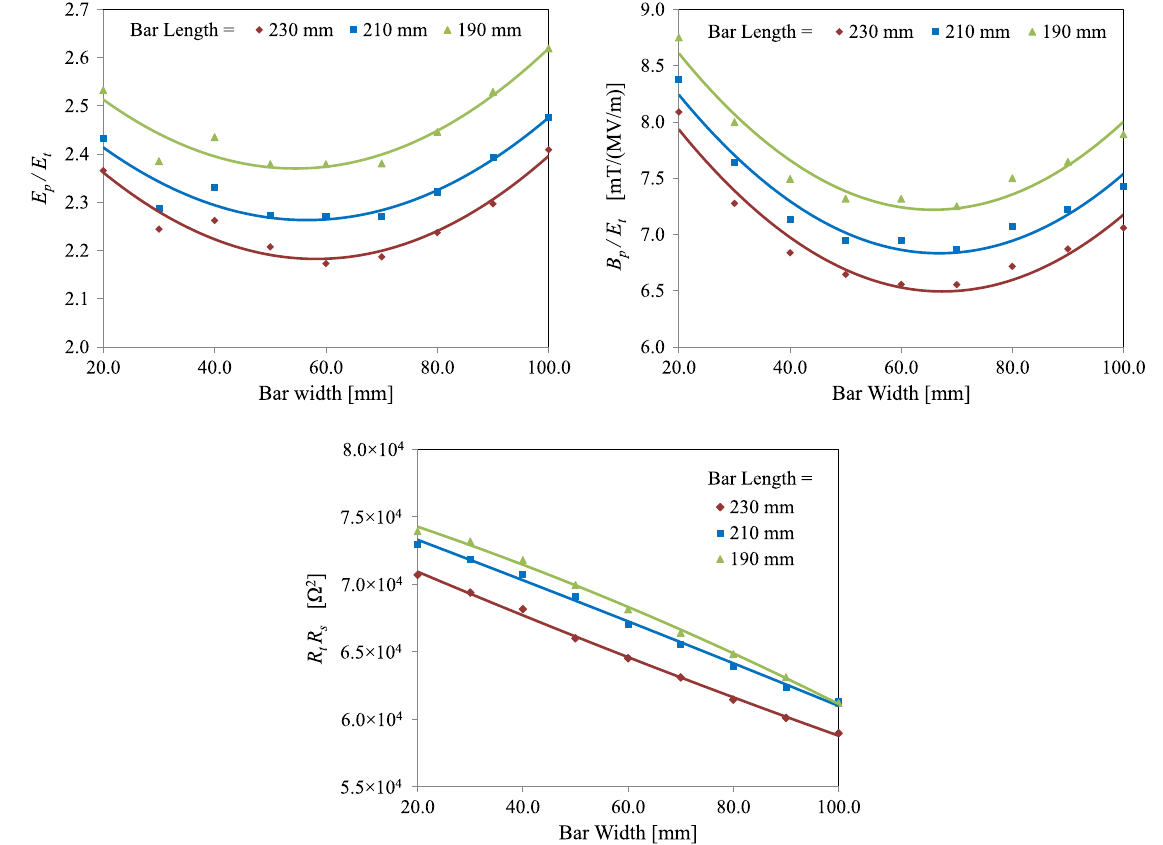
FIG. 17. Ratios of peak surface electric field ( E p ) and magnetic field ( B p ) to the transverse electric field ( E t ) and R t R s with varying bar width and bar length for race-track-shaped parallel bars with cylindrical outer conductor [Design (C)].